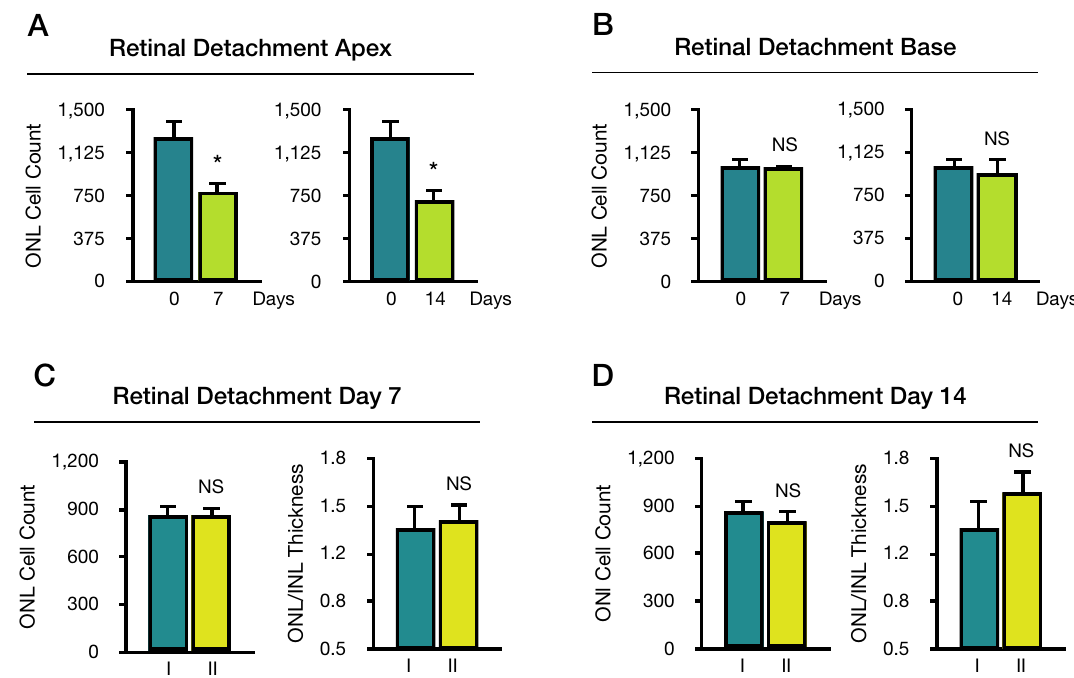
Figure 4. Cases 2 and 3. Case 2: Two-group outer nuclear layer (ONL) cell count comparison between baseline and day 7 or 14 following retinal detachment. ( A ) Retinal detachment apex area. ( B ) Retinal detachment base area. Case 3: Alternate use of apex and base region in retinal detachment. Images from detached apex and base areas were pooled and randomly shuffled to two groups, I and II. ( C ) Comparison between groups I and II